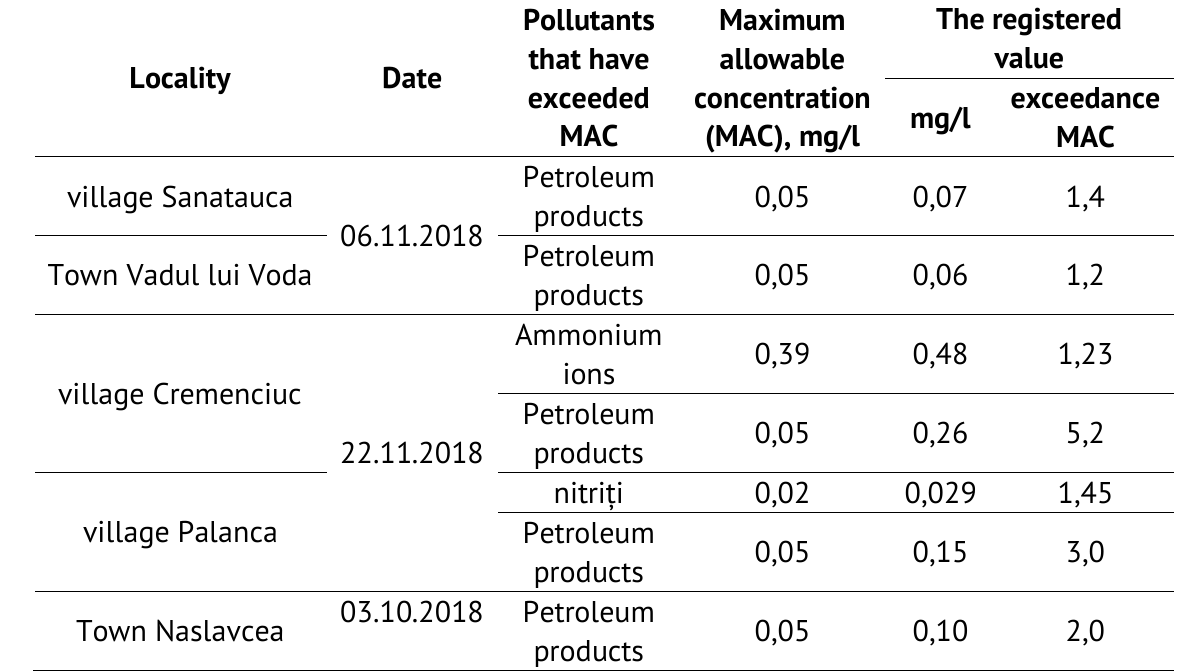
Exceedances of the maximum allowable concentration (MAC) on the Dniester